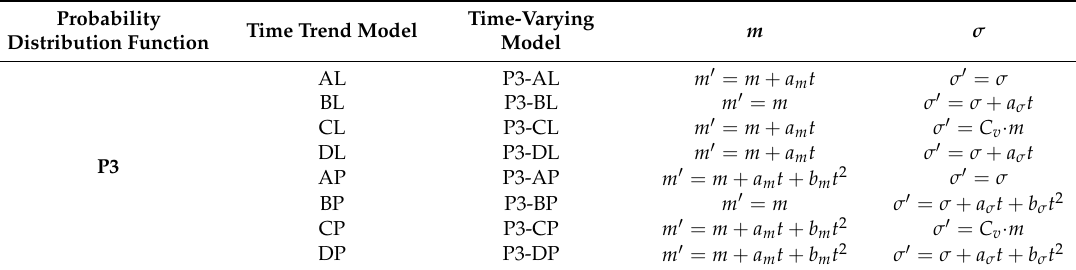
Table 2. Time trend models of the first two